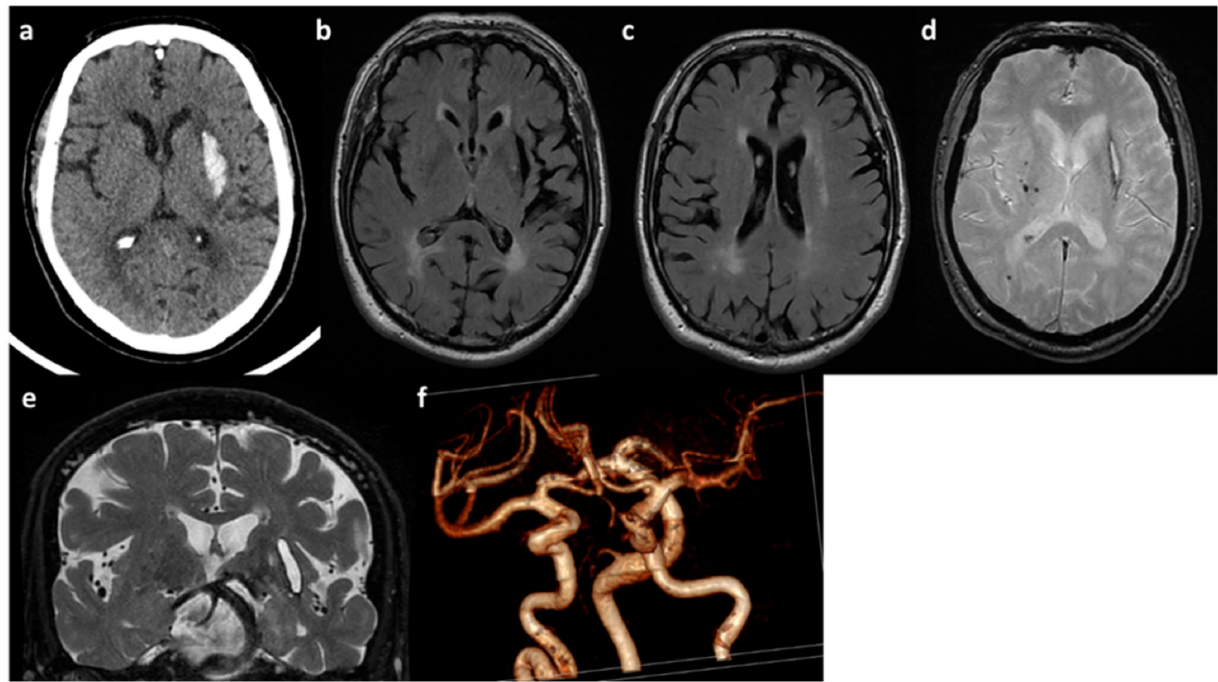
Figure 2. Neuroimaging features of patient B. ( a ) Brain CT with acute left ICH in the external capsule. ( b , c ) Axial FLAIR sequences of brain MRI with leukoaraiosis and cortical atrophy. ( d ) T2* sequence of brain MRI with lobar microbleeds. ( e ) Coronal T2W sequence of brain MRI with enlarged perivascular spaces and dolichoectatic basilar artery. ( f ) MRA (3D reconstruction) showing the main intracranial arteries with dilatative arteriopathy.